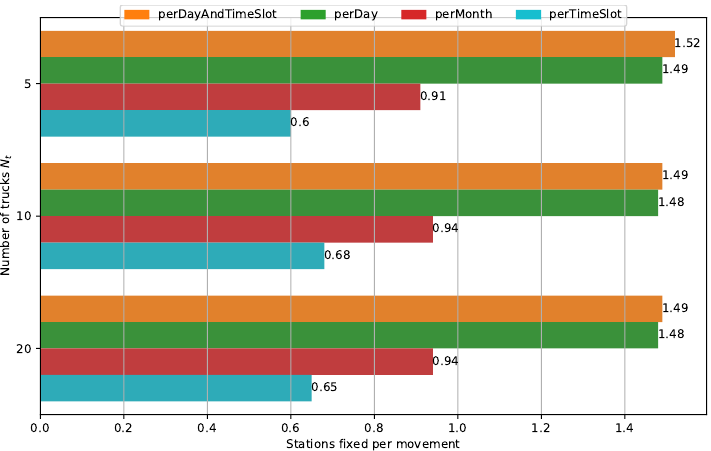
Figure 12. Number of fixed stations per bike movement with varying N t